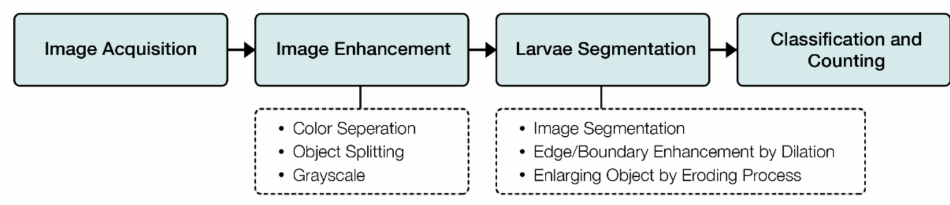
Figure 25. Illustrates the methodology of machine learning